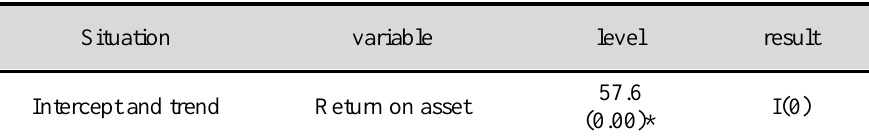
Table 2: unit root test